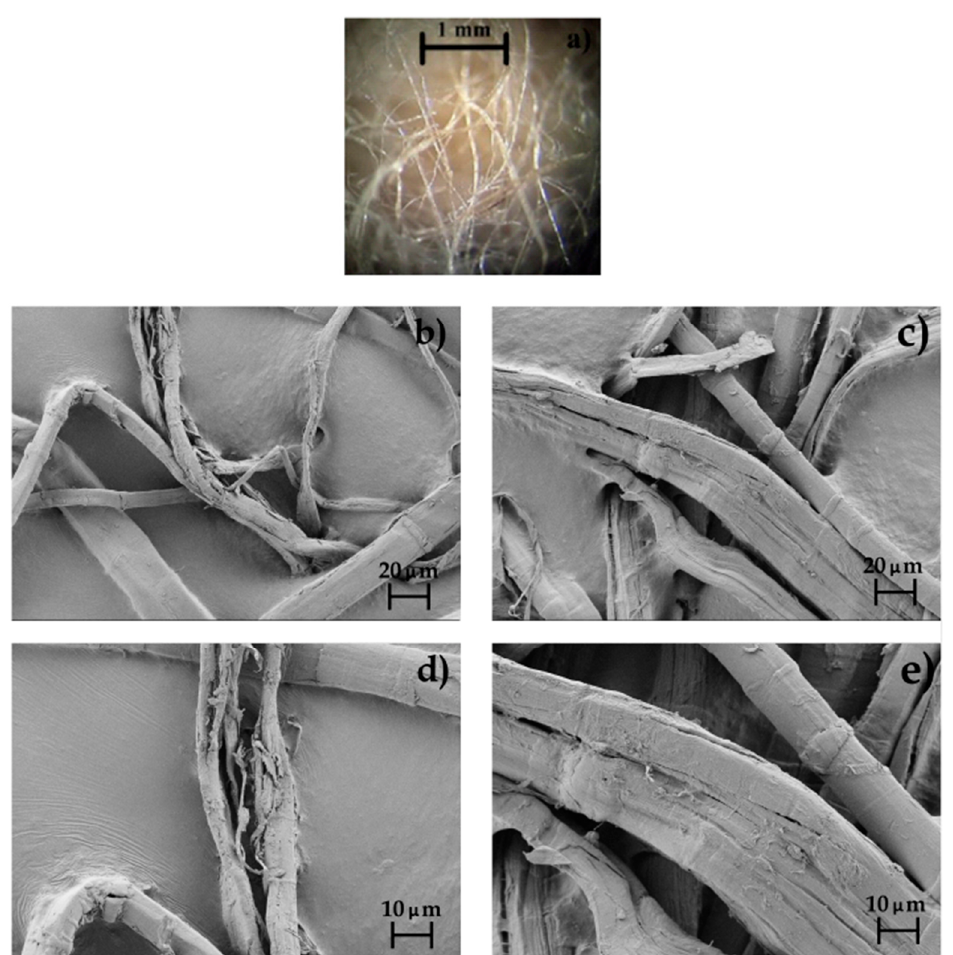
Figure 3. Morphology of the: ( a ) As-received yarn of flaxseed fibers (FFs) taken by optical microscopy at 12.5× with scale maker of 1 mm; ( b ) Alkali-pretreated FFs; ( c ) Alkali-pretreated FFs after silanization taken by field emission scanning electron microscopy (FESEM) at 500× with scale makers of 20 µm; ( d ) Alkali-pretreated FFs; ( e ) Alkali-pretreated FFs after silanization taken by FESEM at 1000× with scale makers of 10 µm.